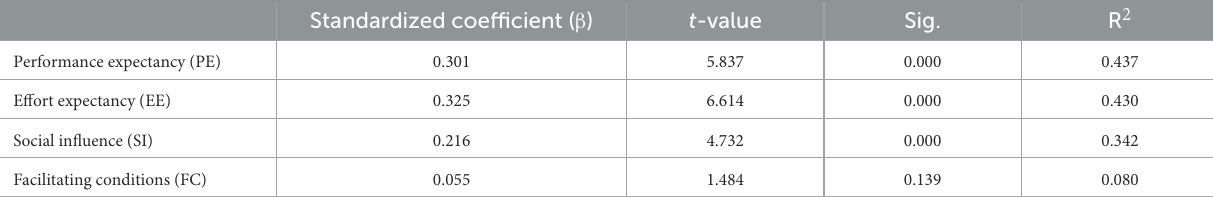
TABLE 3 Regression of factors on the respondents’ behavioral intentions